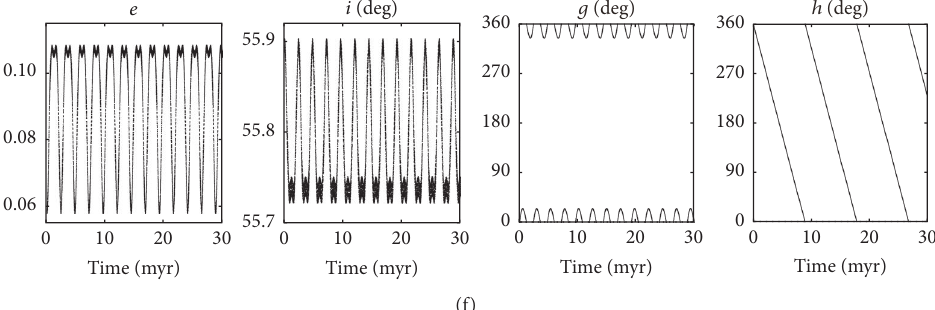
Figure 7: Variation of 𝑒 , 𝑖 , 𝑔 , and ℎ of representative bodies in Figures 6(a)–6(f). Initial values of 𝑒 and 𝑔 for each body are as follows: (a) (𝑒, 𝑔) = (0.14, 𝜋/2) , (b) (𝑒, 𝑔) = (0.50, 𝜋/2) , (c) (𝑒, 𝑔) = (0.34, 0) , (d) (𝑒,𝑔) = (0.15,𝜋/2) , (e) (𝑒,𝑔) = (0.20, 0) , and (f) (𝑒,𝑔) = (0.06, 0) . Note that the unit of 𝑔 and ℎ is degree, not radian, for consistency with the unit of 𝑖 . All the elements are plotted with a time interval of 1500 years and are calculated on the heliocentric coordinate centered on the central